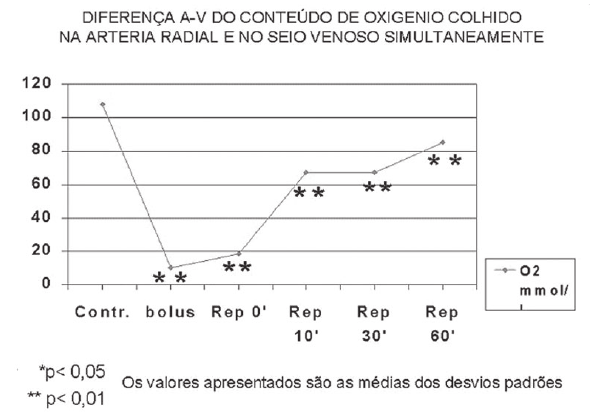
Fig. 2 - Diferença A-V do conteúdo de oxigênio colhido na artéria radial e no seio venoso